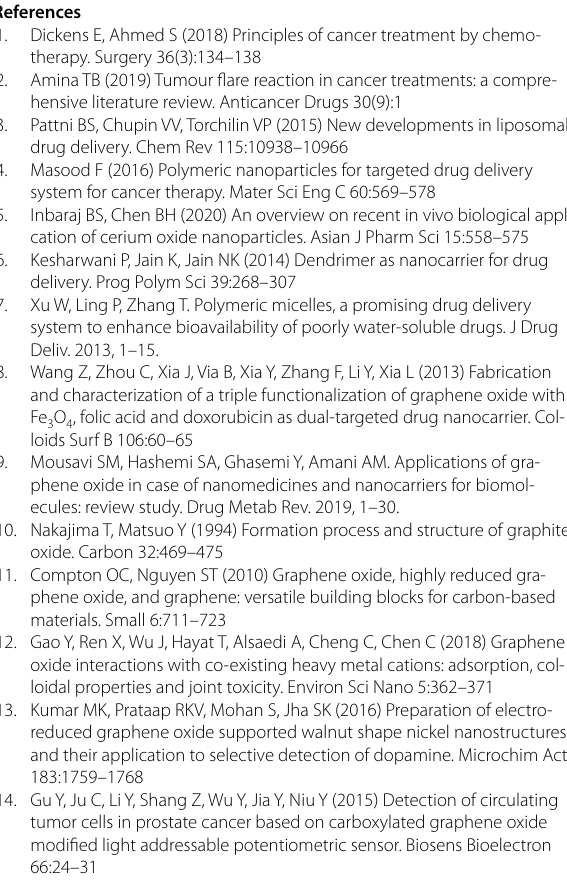
Fig. 16 The drug MSD profiles of the GO and 5-FU ( a ), Tau-GO and 5-FU ( b